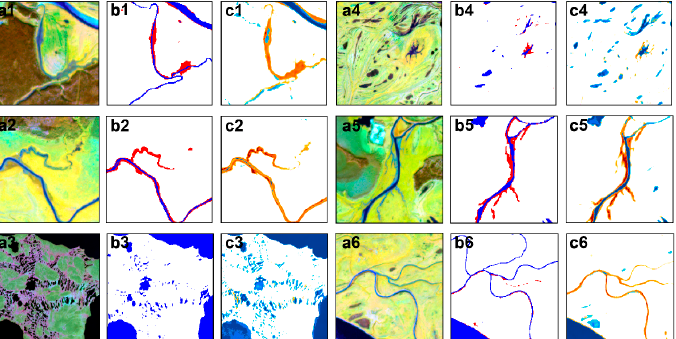
Figure 5. Comparison of mapping seep areas for 6 different sites: ( a1 – a6 ) Sentinel-2 images; ( b1 – b6 ) RF classifier map overlaid by streams and rivers from OSM layer (blue—open water, red—seep areas; used as a label layer for CNN); ( c1 – c6 ) CNN map (blue and orange gradients—open water and seep areas of different probabilities within output map, respectively). The seep areas were estimated at 2885 km 2 or 1.5% of the studied region; among them, 412 km 2 (0.2%) were covered by seep areas of high probability (>40% on the CNN output map). Open water areas occupy 5 times larger areas (almost 16,000 km 2 or 8.3%) of the region. Visual inspection supports this ratio: most seep areas manifested as narrow